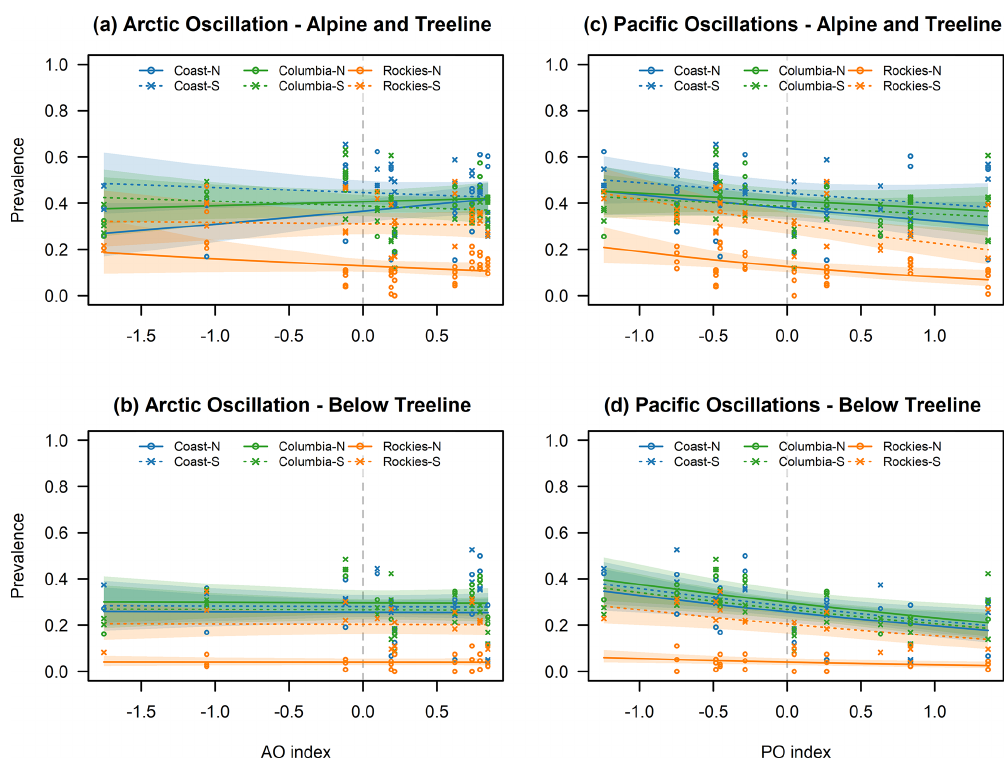
Figure 5. Calculated prevalence for storm slab avalanche problems in relation to AO (a, b) and Pacific-centered oscillations (c, d) for the alpine/treeline (a, c) and below treeline (b, d) over the range of observed index values. Lines indicate the mean estimates, and shaded areas represent the 95% confidence intervals. Individual points represent observed prevalence